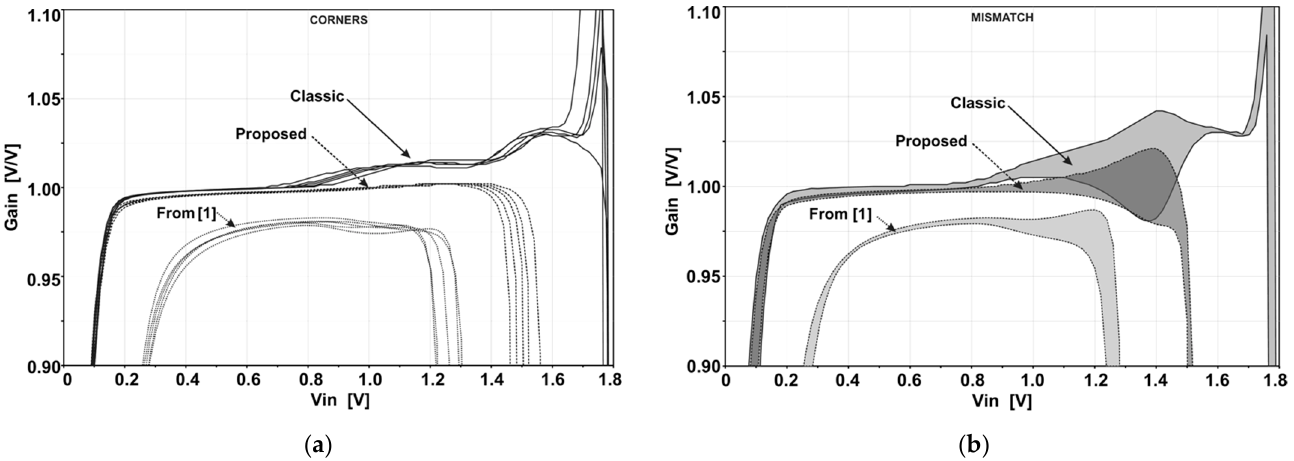
Figure 5. Simulated sensitivity of gain to: ( a ) process corners (nominal and four corners: wz, wo, ws, wp); ( b ) mismatch (500 monte carlo runs).